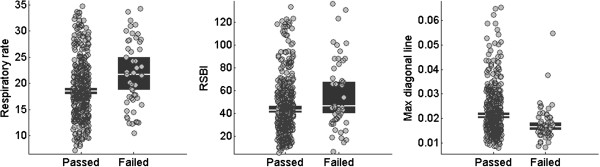
Distributions of respiratory rate (RR),rapid shallow breathing index (RSBI) and variability. This figure shows the distribution of values for passed and failed of three different measures (from the left: respiratory rate, rapid shallow breathing index, and respiratory rate variability recurrence quantification analysis: maximal diagonal line). Each grey circle represents a subject. The black box with a white line in between represents the median with its 95% confidence interval.